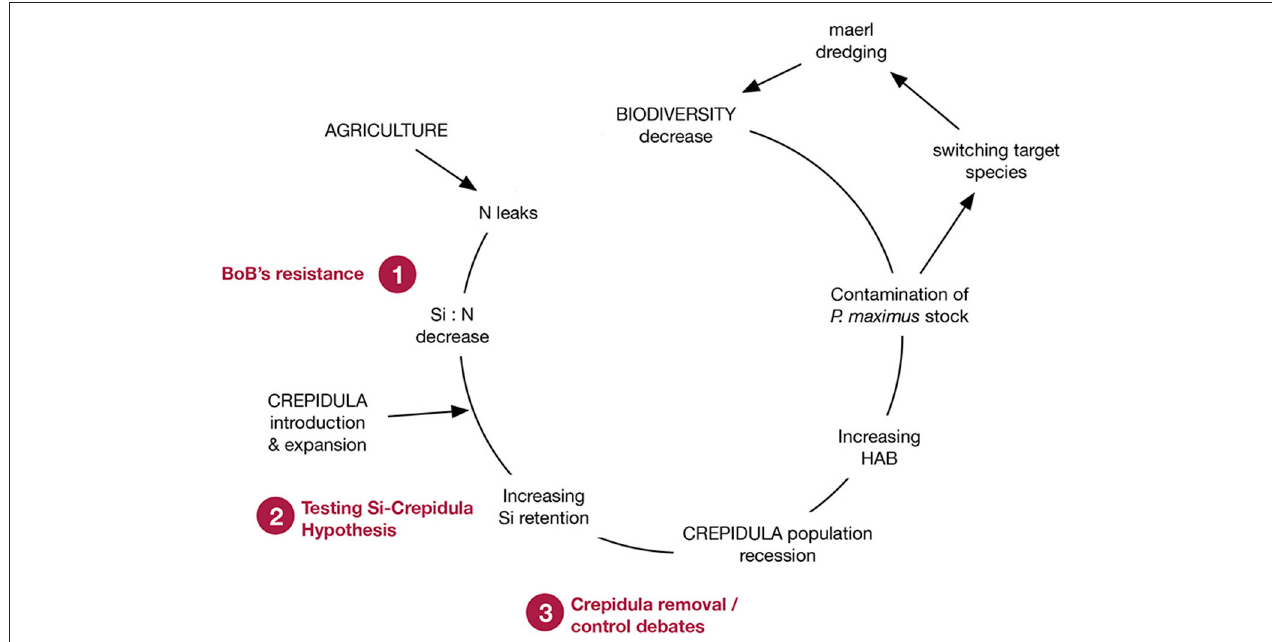
FIGURE 5 | Scientific questions that were raised between 1995 and 2005, concerning the long resistance of the ecosystem to the effects of increasing N delivery from land and changing nutrient ratios (1), the emergence and the testing of the Si/ Crepidula hyporthesis (2) and the key questions raised at the science-policy-community interface concerning a possible control of the Crepidula proliferation